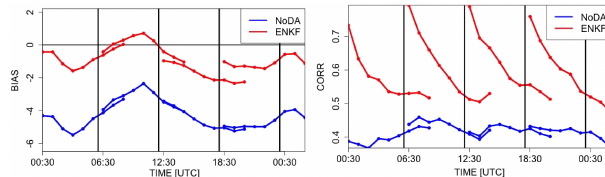
Figure 5. Diurnal cycle of bias (µgm − 3 ) (left) and spatial correla- tion (right) of PM 2 . 5 forecasts for the NoDA (blue) and EnKF (red) simulations against AIRnow observations for the period 28 June– 6 July 2012. The black vertical lines are plotted at assimilation